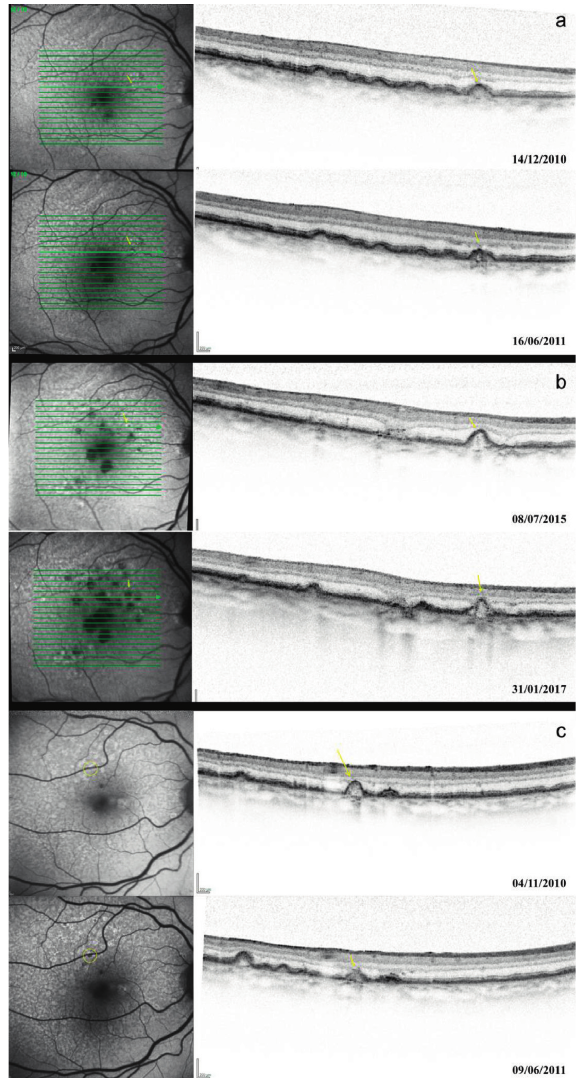
Figure 3: Examples of simultaneous detection, earlier detection with FAF, and earlier detection with SD-OCT. FAF: fundus auto- fluorescence; RPE: retinal pigment epithelium; and SD-OCT: spectral domain optical coherence tomography. (a) Simultaneous detection (the incipient RPE atrophy was observed at the same time with both exams). In the top image (14/Dec/2010), the selected druse (yellow arrow) showed normal autofluorescence on FAF and no hypertransmission on SD-OCT. In the next visit (16/Jun/2011), incipient atrophy of the RPE by both imaging techniques was observed. (b) Earlier detection with FAF (RPE atrophy overlying drusen is detected earlier on FAF than on SD-OCT). The top image (08/Jul/2015) shows that while a marked area of absence of autofluorescence appears on FAF, no signs of RPE atrophy were detected with SD-OCT. In the bottom image (31/Jan/2017), after 18months, signs of atrophy on SD-OCTcan be observed and the area of atrophy on FAF increased in size. (c) Earlier detection with SD-OCT. In the top image (04/Nov/2010) there is SD-OCT hypertransmission (yellow arrow), but normal FAF. Seven months later (09/Jun/2011), the absence of autofluorescence was noticeable (bottom